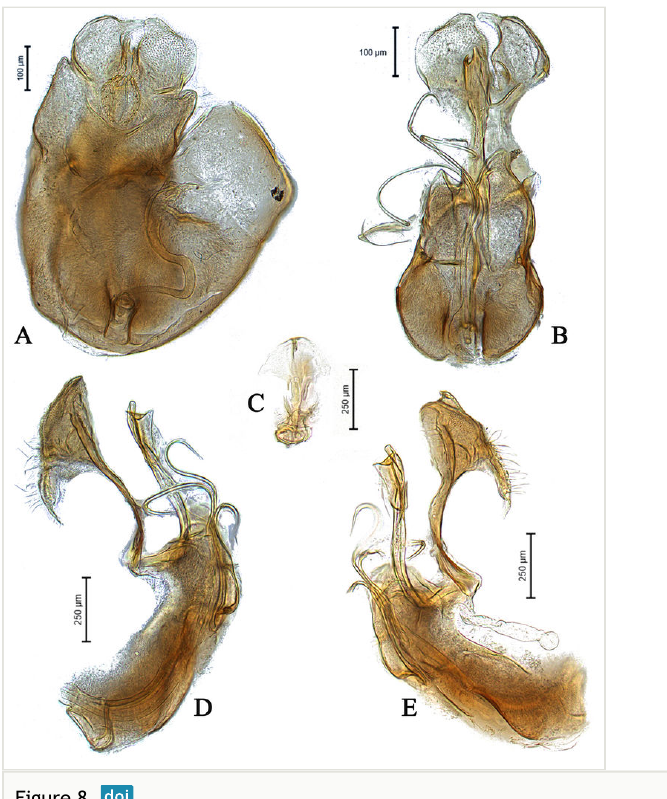
Figure 8. Male genitalia of Eudorylas blascoi (JSS52179) (A) in dorsal view; (B) in ventral view; (C) ejaculatory apodeme; (D, E) in lateral